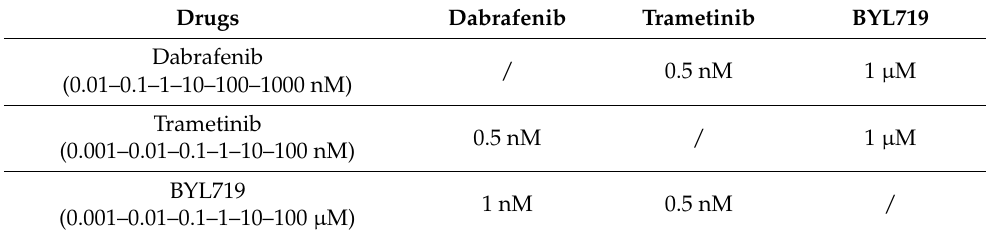
Table 1. Cell lines